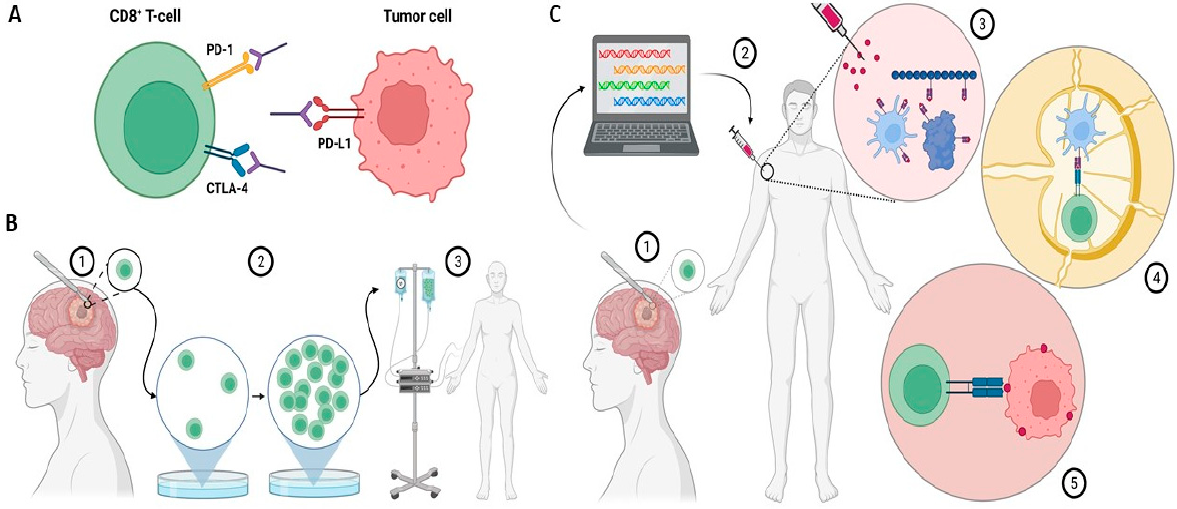
Figure 1. ( A ) Immune checkpoint inhibitors bind to and inhibit immunosuppressive molecules on either T-cells or tumor cells. This dampens tumor cells ′ ability to evade the immune system. ( B ) (1) In tumor-infiltrating lymphocyte (TIL) therapy, T-cells from the tumor microenvironment are isolated following surgical resection. (2) Isolated T-cells are clonally expanded by using IL-2 stimulation. (3) Expanded T-cells are reintroduced to the patient. ( C ) (1) In the vaccine approach, a resected tumor biopsy is taken from the patient and sequenced to identify neoantigens. (2) Neoantigens are then delivered via a vaccine. (3) At the site of injection, neoantigens stimulate antigen-presenting cells (APCs). (4) In the lymph node, APCs present T-cells with neoantigens. (5) Activated T-cells attack cancer cells. Created with BioRender.com.